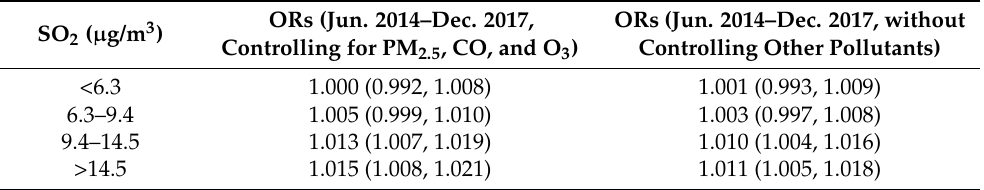
Table 3. Influence of SO 2 on gynecological cancers in Phase 4 with/without control of other air pollutants.